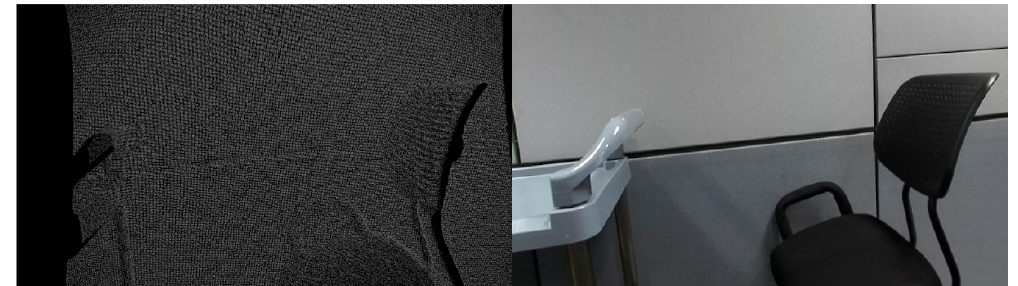
Figure 3. Holes in the reprojected depth map and corresponding color image.